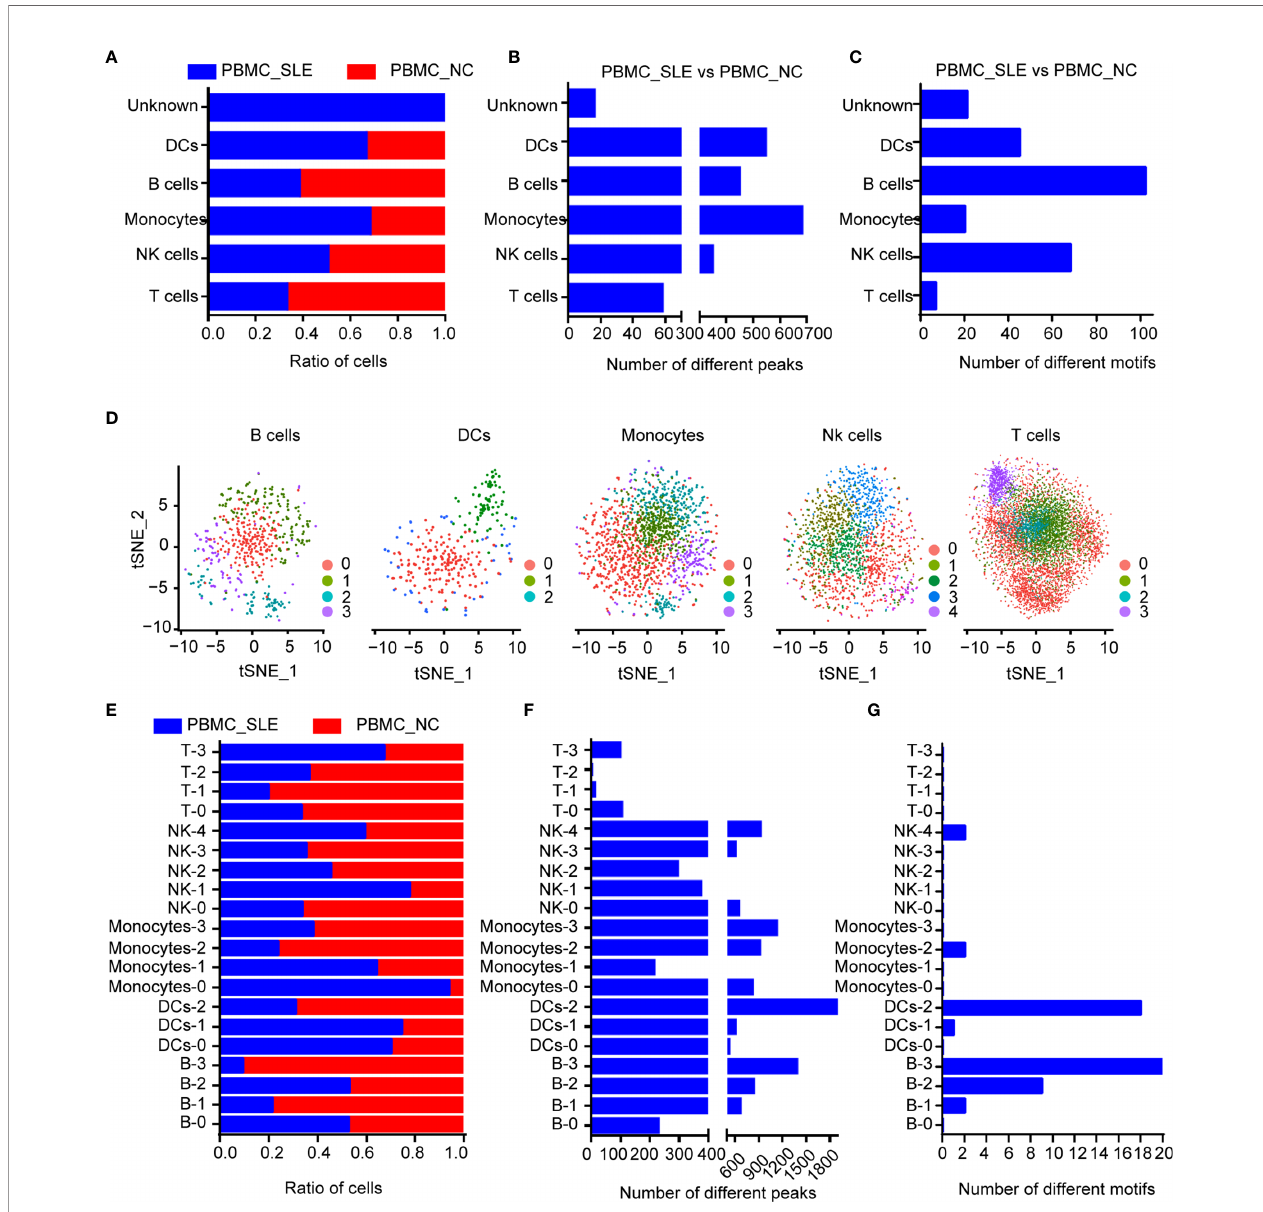
FIGURE 2 | Epigenomic analysis of human PBMCs. (A) Cell ratios in each cell type for comparison between the SLE_PBMC and NC_PBMC libraries; (B) Number of different peaks in each cell type for comparison between the SLE_PBMC and NC_PBMC libraries (p <0.05); (C) Number of different TF motifs in each cell type for comparison between the SLE_PBMC and NC_PBMC libraries (p <0.05); (D) tSNE plot of B cells, DCs, monocytes, NK cells and T cells, color-coded by their associated subcluster; (E) Cell ratios in each subcluster for comparison between the SLE_PBMC and NC_PBMC libraries; (F) Number of different peaks in each subcluster for comparison between the SLE_PBMC and NC_PBMC libraries (p <0.05); (G) Number of different TF motifs in each subcluster for comparison between the SLE_PBMC and NC_PBMC libraries (p <0.05); PBMCs, peripheral blood mononuclear cells; SLE_PBMC, PBMCs from patients with systemic lupus erythematosus (SLE); NC_PBMC, PBMCs from healthy controls; NK cells, natural killer cells. The p-values were calculated with Loupe Cell Browser 3.1.1 through the difference analysis feature and adjusted using the Benjamini – Hochberg correction for multiple